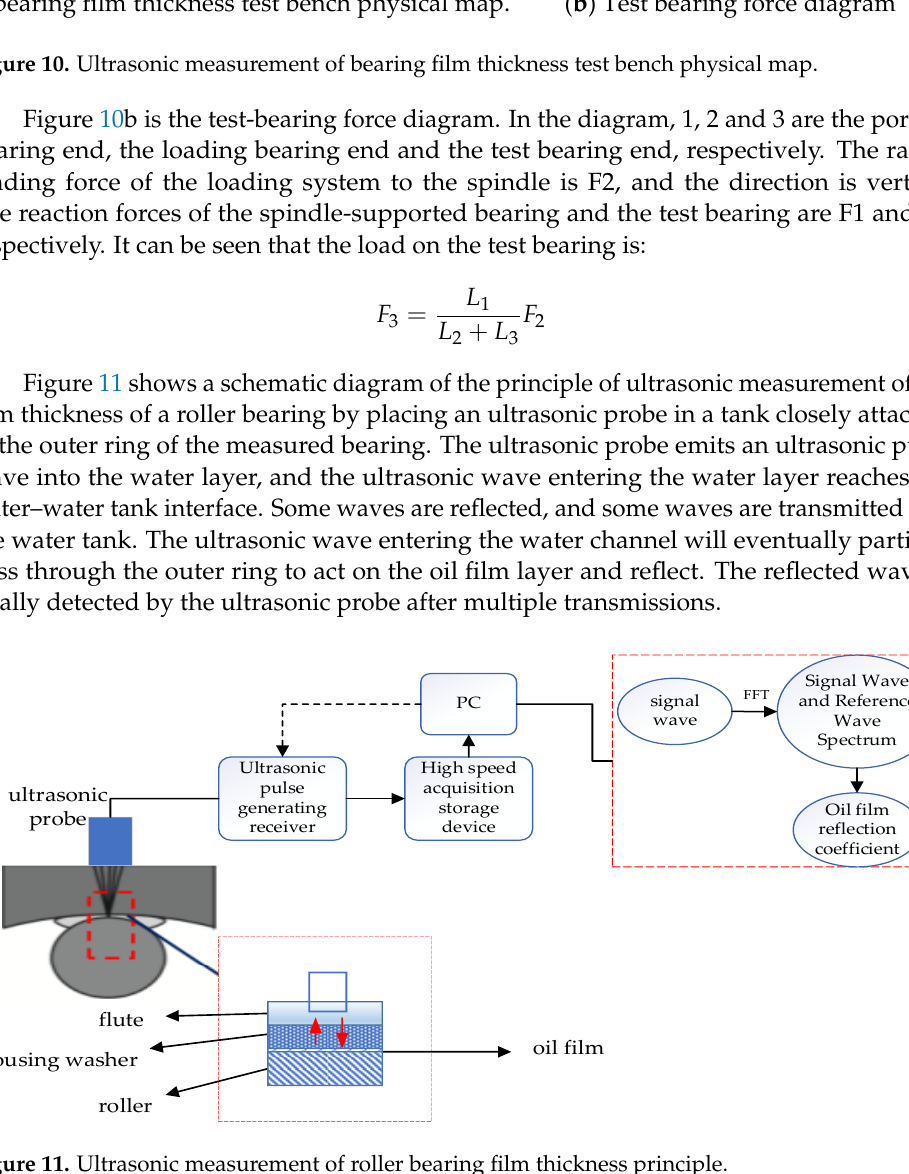
Figure 10. Ultrasonic measurement of bearing film thickness test bench physical map.